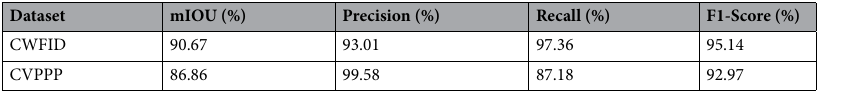
Table 7. Segmentation labeling result; applying the proposed algorithm to the CWFID and CVPPP datasets.